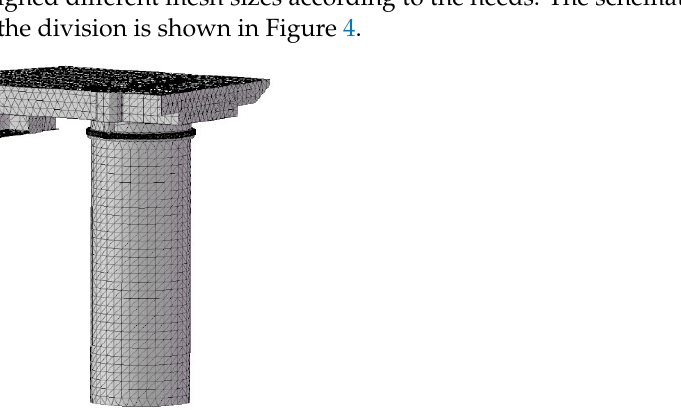
Figure 4. Schematic diagram of the meshing results of the Simulation module.